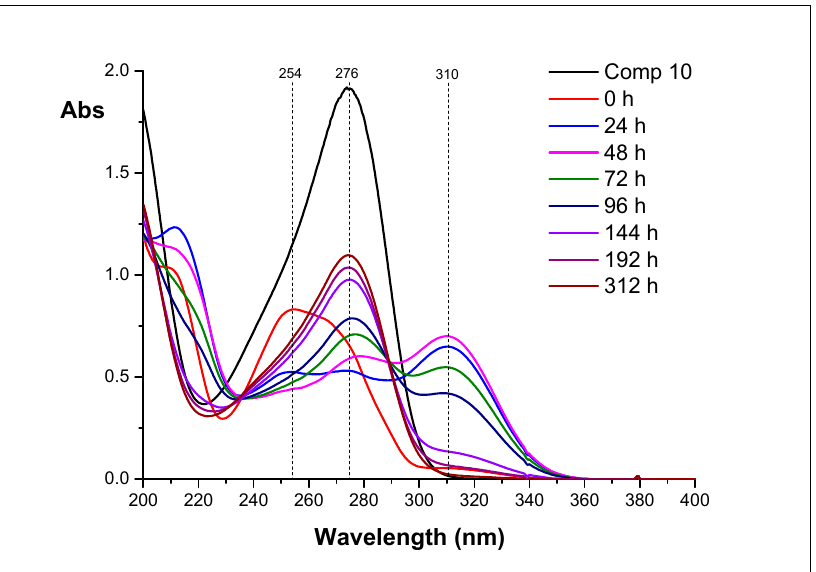
Figure 8. The UV spectra of the reaction mixtures obtained during hydrolysis of 12 (D 2 O, appeared pH 4.1).